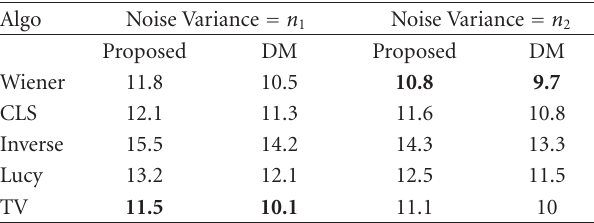
Table 3: Comparison of Proposed and Distortion measure of Experiment